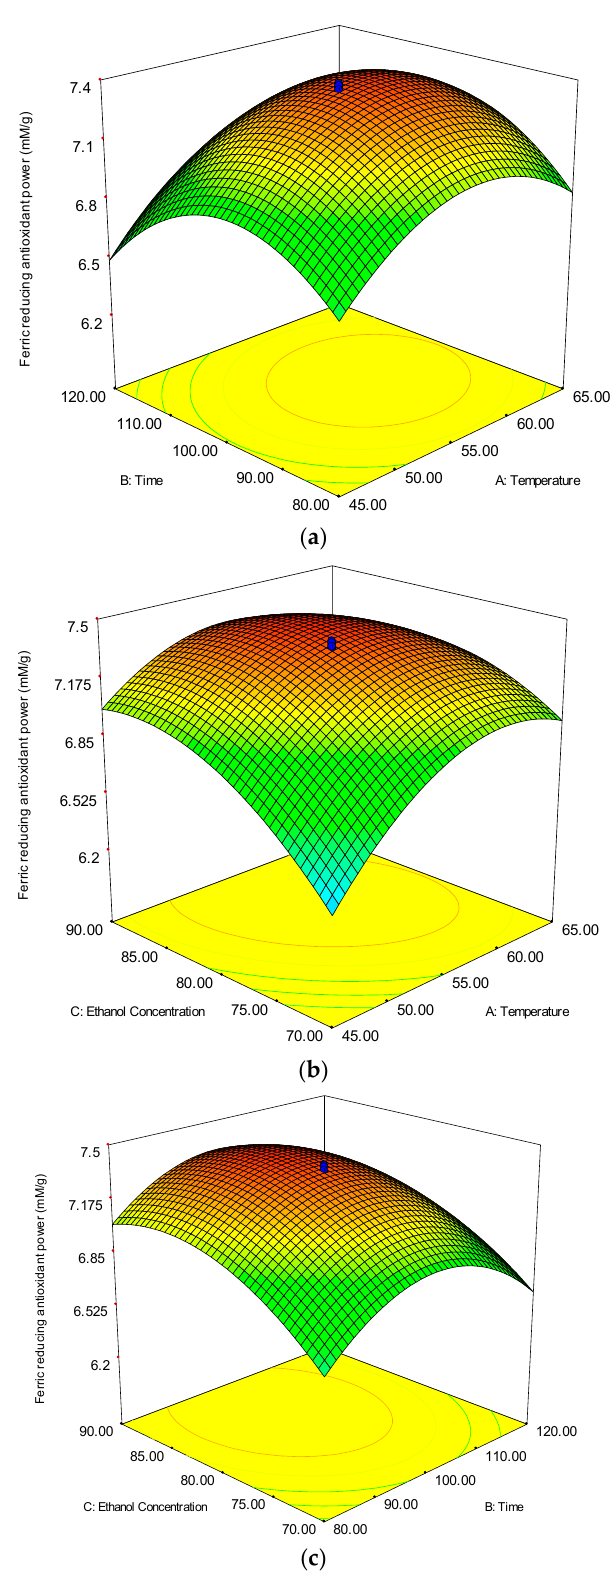
Figure 2. The response surface (3D) and contour plots showing the effect of extraction temperature and time ( a ); temperature and ethanol concentration ( b ); extraction time and ethanol concentration ( c ) on the ferric reducing antioxidant power of the red pitaya peels.